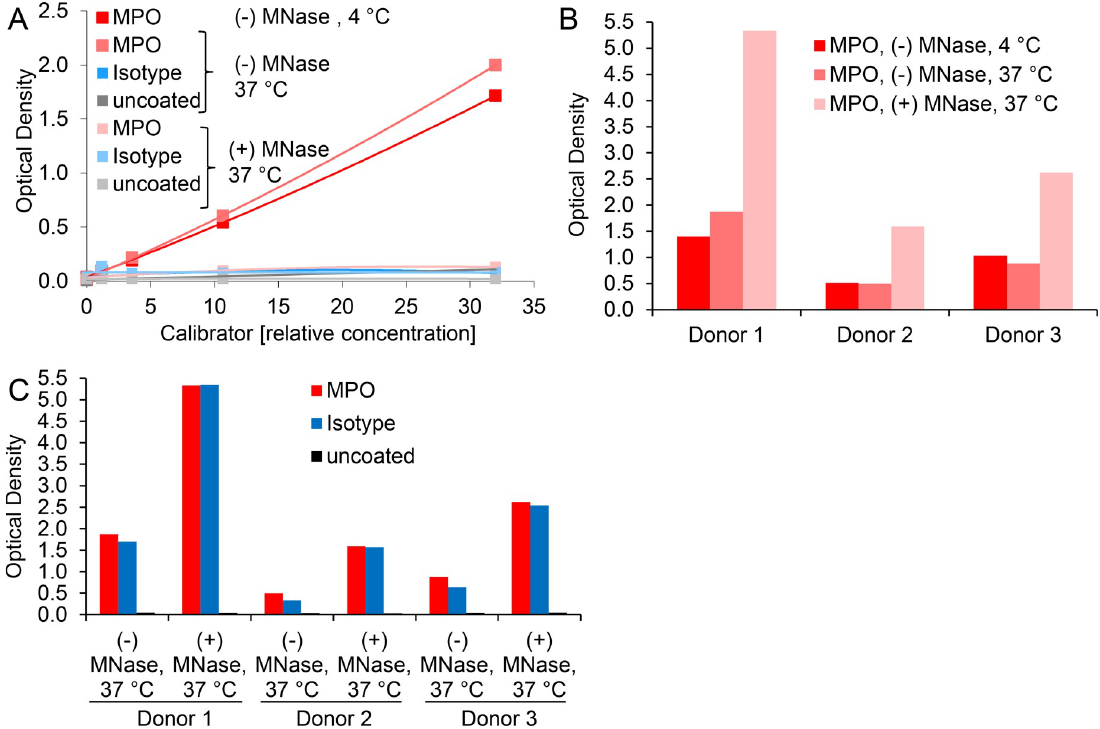
Fig 5. DNA degradation abolishes detection of in vitro generated MPO-DNA complexes but enhances unspecific plasma signals. A) Calibrator or B) and C) plasma DNA was digested with (+) A) 2 U/ml or B) and C) 20 U/ml MNase at 37˚C for 60 min. Control samples were incubated at 37˚C or kept on ice (4˚C), both without (-) MNase supplementation. Microwells were A) and C) coated with MPO antibody, isotype control or were left uncoated or B) coated with MPO antibody only. The further ELISA procedure was performed as outlined for the initial MPO-DNA complex ELISA protocol. Plasma was applied at a final dilution of 1:2. Donors 1–3 are identical in B) and C).